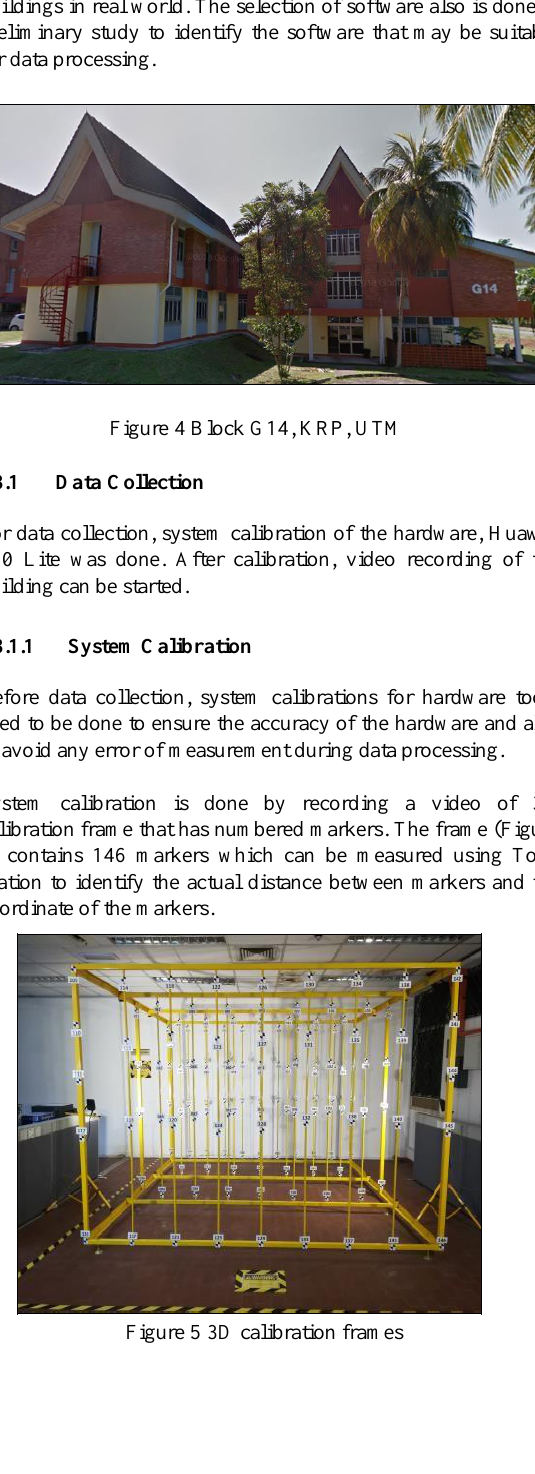
Figure 5 3D calibration